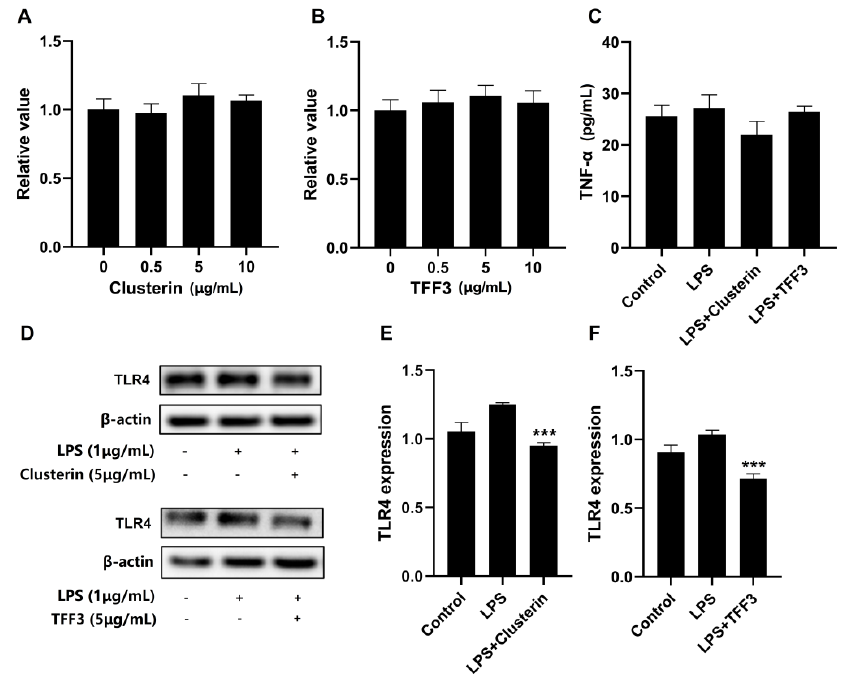
Figure 8. Inhibitory effect of clusterin and TFF3 macrophage inflammation in RAW264.7 cells ( A , B ) RAW264.7 cells treated with clusterin or TFF3 (0, 0.5, 5, 10 µ g/mL) for 8 h. The cell viability was detected using Cell − Counting − Kit − 8 ( C ) RAW264.7 cells were pretreated with clusterin or TFF3 (5 µ g/mL) for 8 h after co − incubation with LPS (1 µ g/mL) for 8 h. The TNF − α level was detected using ELISA kits. ( D – F ) RAW264.7 cells treated with clusterin or TFF3 (5 µ g/mL) for 8 h after incubating with LPS (1 µ g/mL) for 8 h. The expression of TLR4 was detected using Western blotting. *** p < 0.001 versus the LPS induced